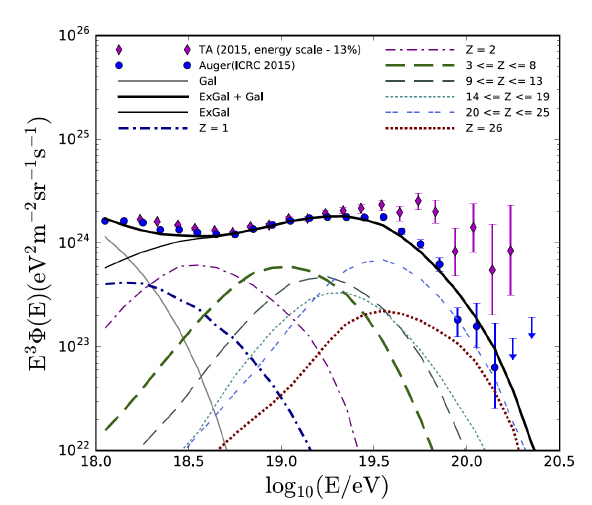
Figure 15. Reconstruction of the observed UHECR spectrum in a multi-FR I source scenario, assuming as reference a mildly relativistic ( β (cid:39) 0.7) jet of width r j = 0.5 kpc surrounded by a narrow transition layer of width ∆ r = 5 pc ( B j = 0.3 mG). The chemical composition at the highest energies is dominated by intermediate and heavy nuclei. From ref. [134].